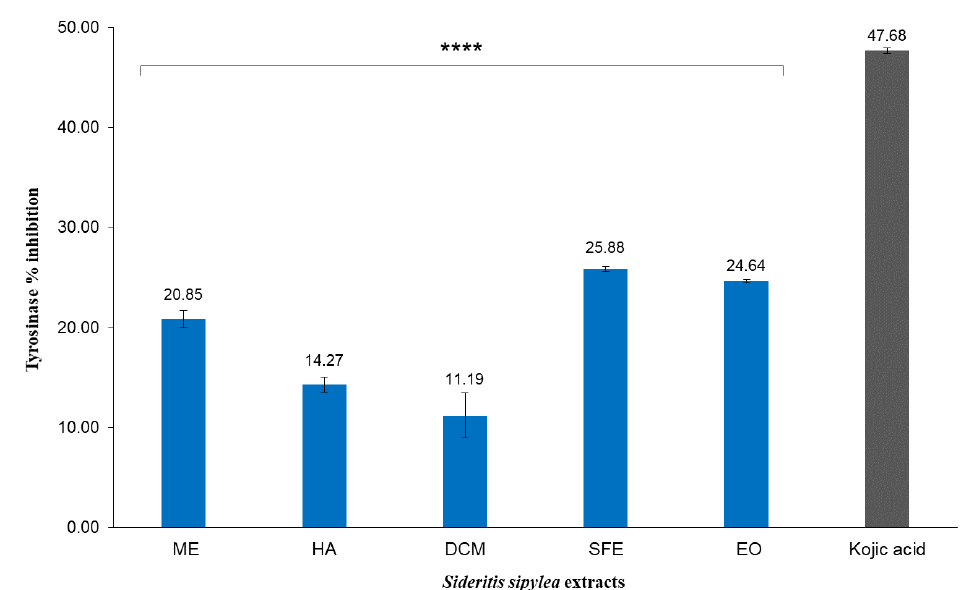
Figure 4. Tyrosinase inhibitory effect of the methanol (ME), water/methanol (HA), dichloromethane (DCM) and supercritical fluid (SFE) extracts, along with the essential oil (EO) of S. sipylea at 150 µ g / mL. The values are the mean of three replicate determinations ± standard error. Kojic acid was used as a positive control at 150 µ g / mL. Statistical analysis was performed by one-way ANOVA, and Dunnett’s test was employed to compare extracts with the positive control, with p < 0.0001 (****).